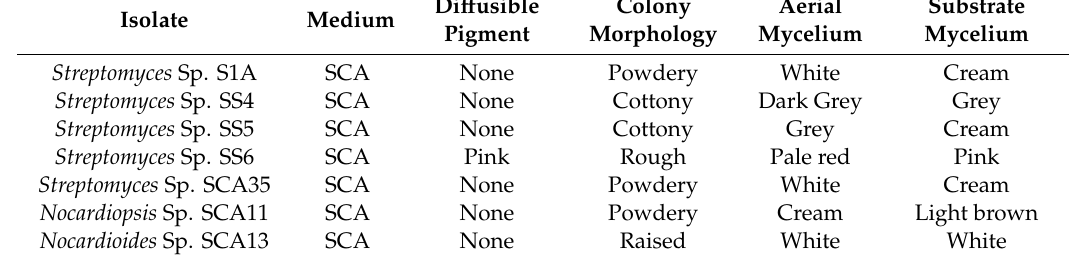
Table 2. Morphological characteristics of isolated actinobacterial strains.